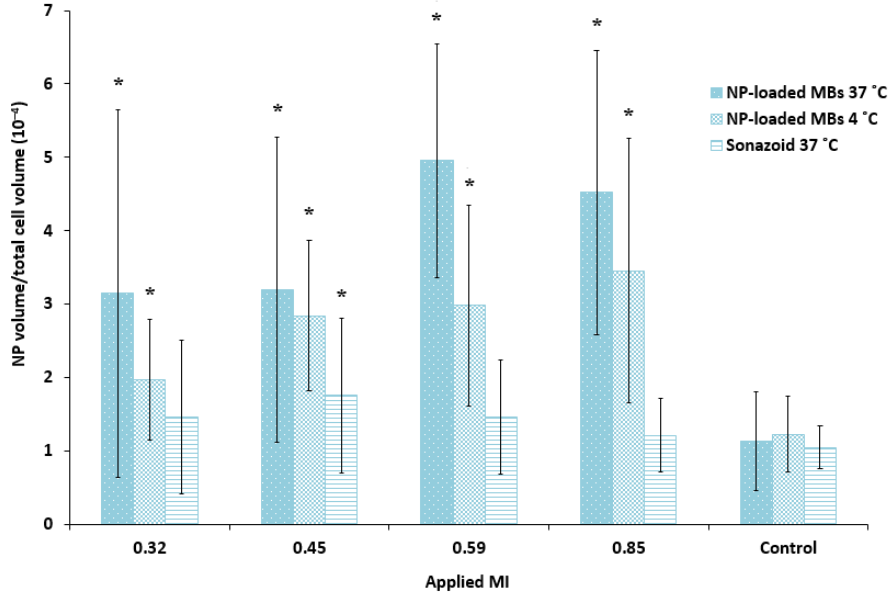
Figure 6. Quantitative comparison of the cellular uptake of nanoparticles (NP) after ultrasound treatment of various MIs using nanoparticle-loaded bubbles (NP-loaded MBs) at 37 ◦ C and 4 ◦ C, compared to the lipid Sonazoid microbubbles at 37 ◦ C. Data show the total number of nanoparticle voxels relative to the total number of cell voxels in the z-stack (nanoparticles both inside cells and colocalized with the cell membrane are included). Averages and the standard deviation are shown from n = 17–18 z-stacks at 37 ◦ C and n = 8–9 at 4 ◦ C, and * indicates significant differences ( p < 0.05) compared to the untreated control cells.